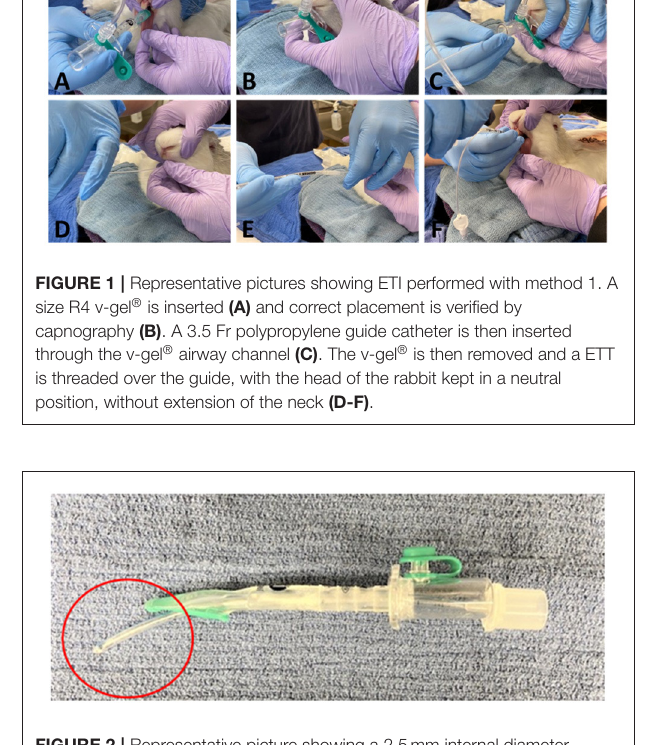
Method 1 : Figure 1 after placement of the v-gel R (cid:13) (v-gel R (cid:13) ,